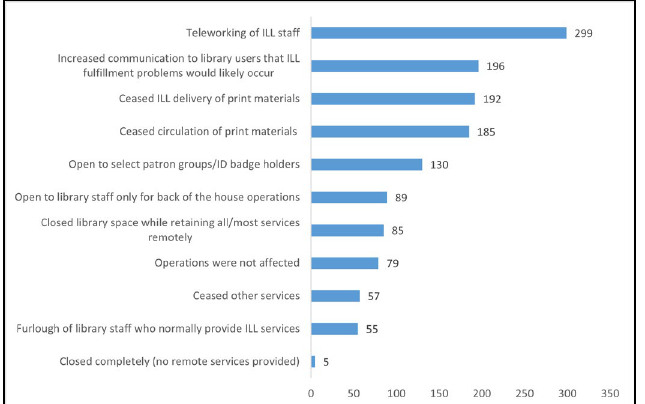
Figure 1 Percentage of Respondents (N=431) Reporting Various Impacts on Library Operations (1372 responses).